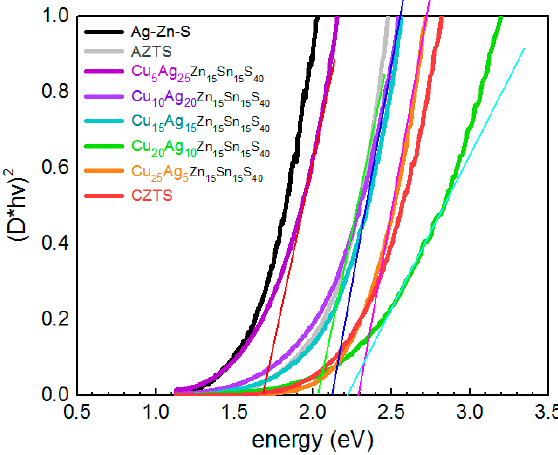
Figure 11. UV-vis absorption spectra of the (Cu 1 − x Ag x ) 2 ZnSnS 4 NC